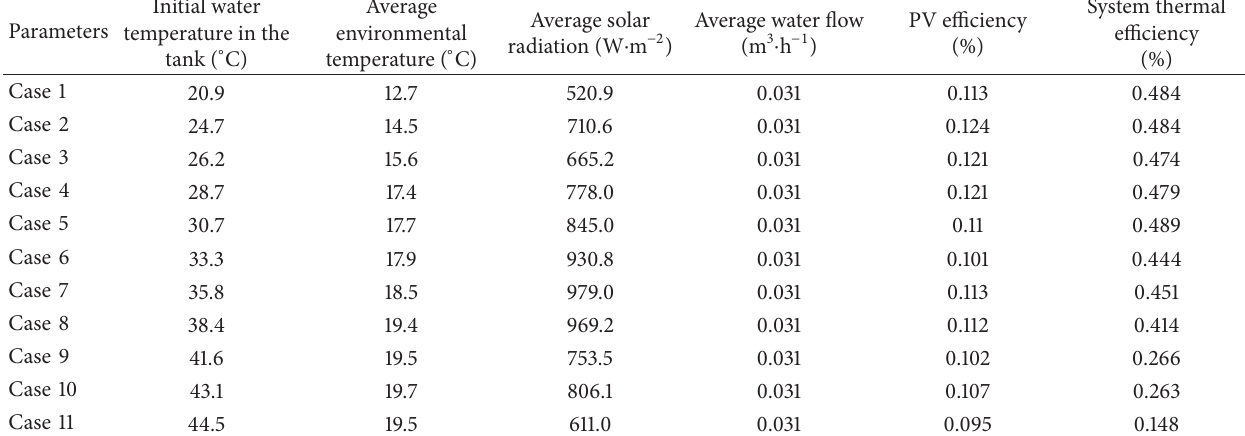
Table 3: List of experimental results.